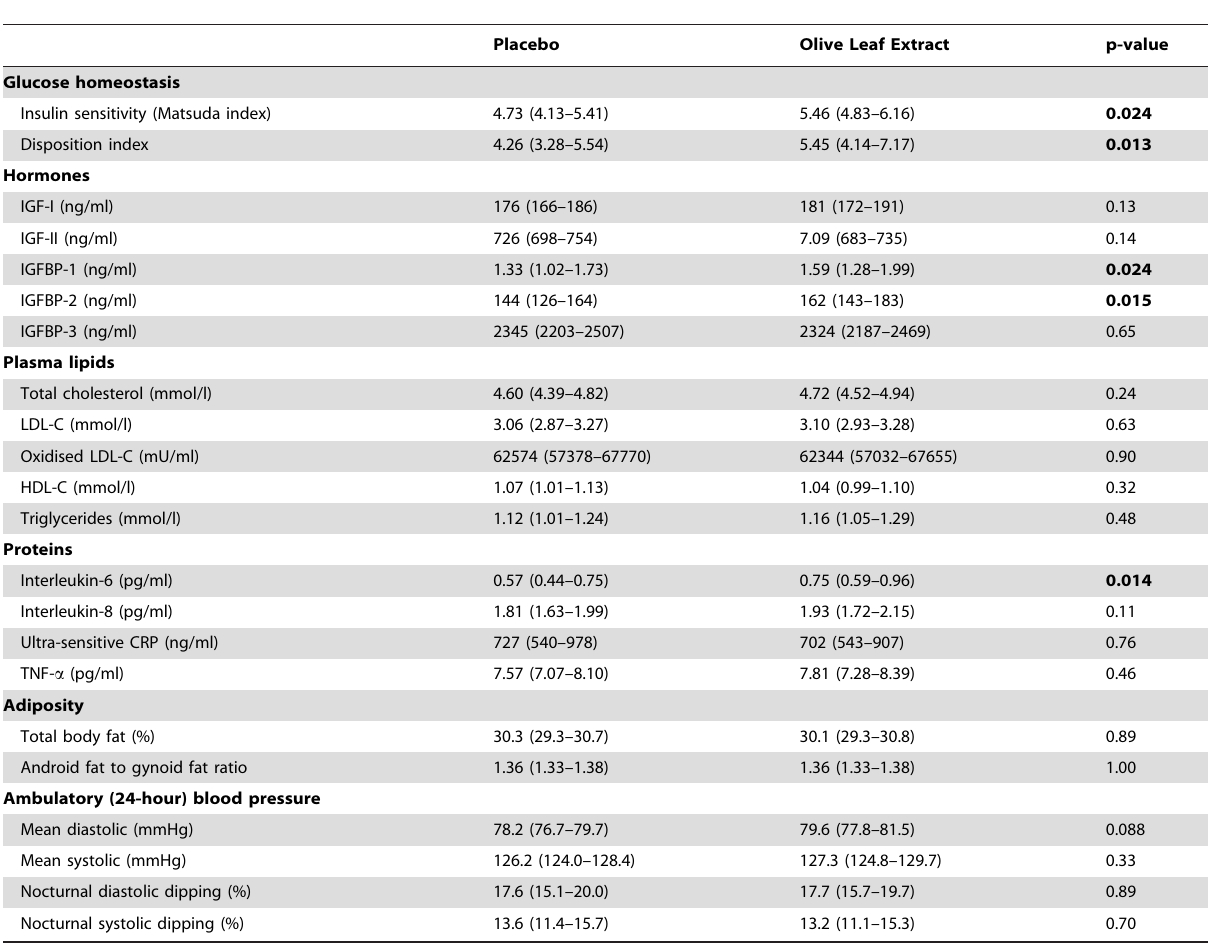
Table 3. Outcomes following a 12-week supplementation with olive leaf extract or placebo (n= 45).